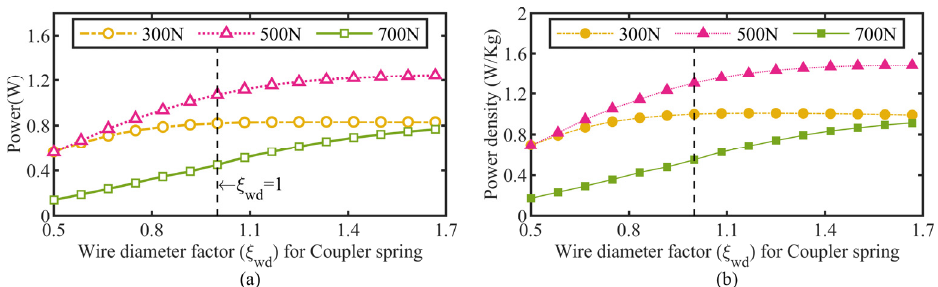
Figure 11. Effects of wire diameter of coupler spring on actuator performance. ( a ) Power versus wire diameter factor; ( b ) power density versus wire diameter factor.